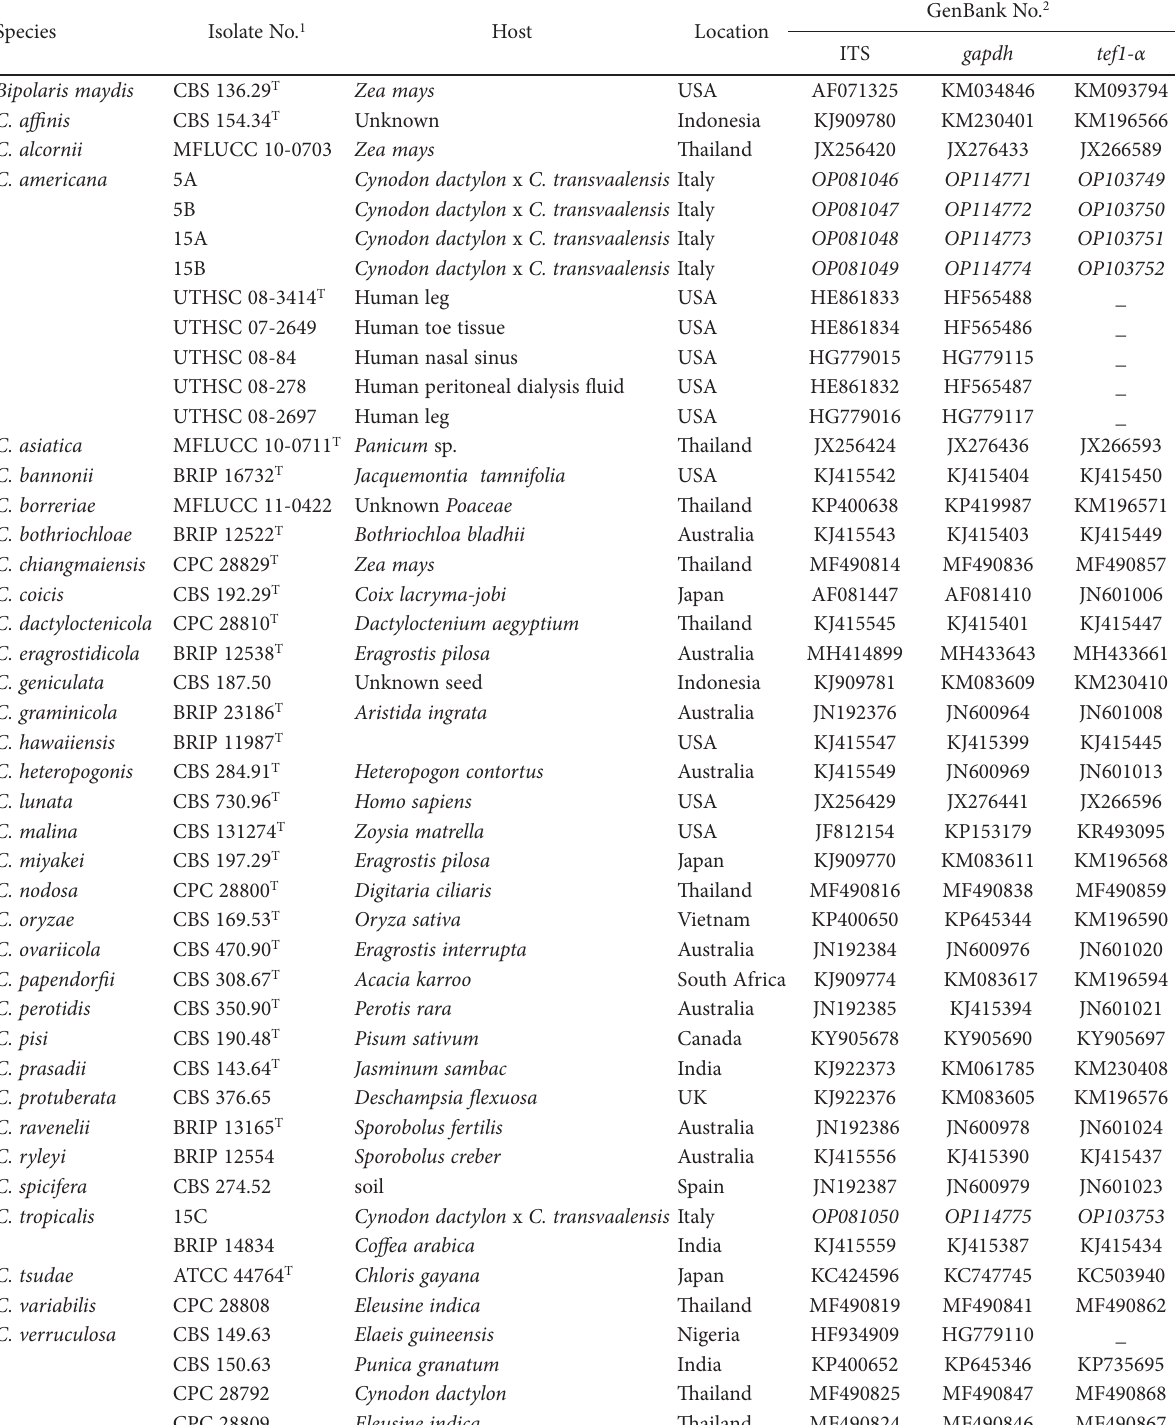
GenBank No. 2 ITS gapdh tef1-α